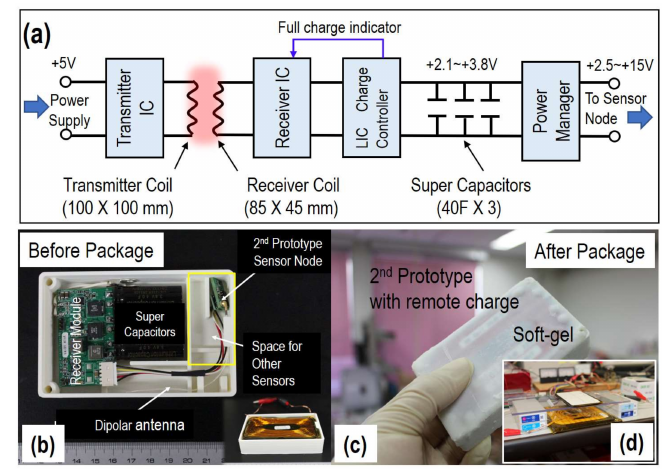
Figure 2. Schematic view of the wireless power transmission system, which includes a power transmitter module and power receiver module ( a ); photos of the second prototype sensor node with wireless power receiver module before ( b ) and after packaging ( c ); and photo of the evaluation system ( d